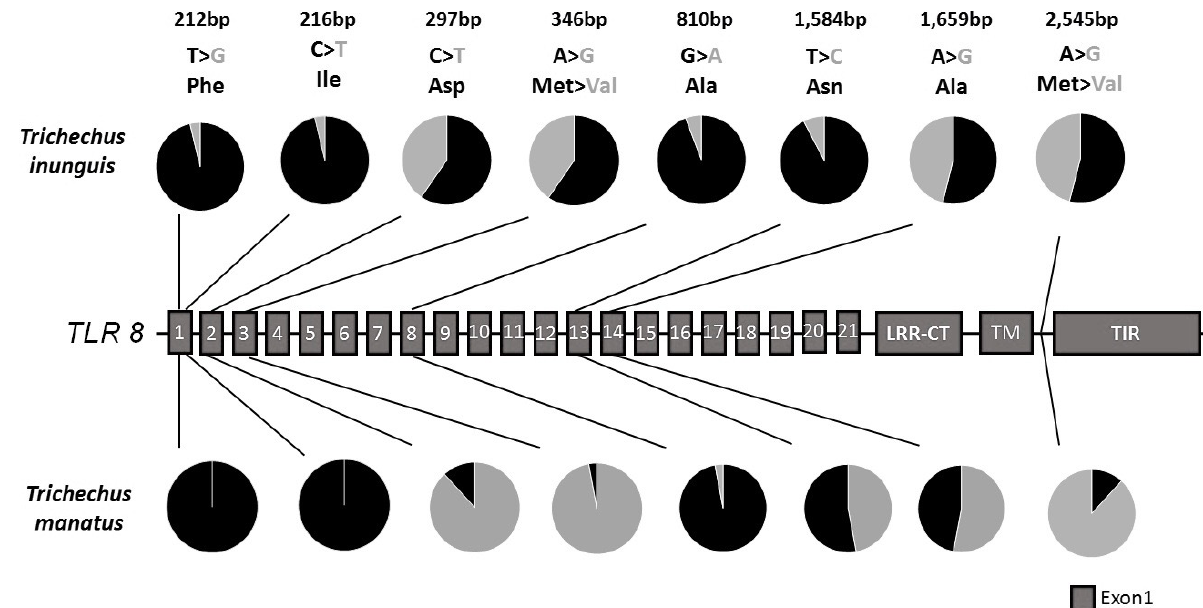
Figure 3 – Identification of SNPs in the structure of the TLR8 gene. In the graph the higher frequency of nucleotides is represented in black with synonymous and non-synonymous occurrences in two populations of manatees. The cartoon structure is represented by exon 1 (red). Rectangles represent